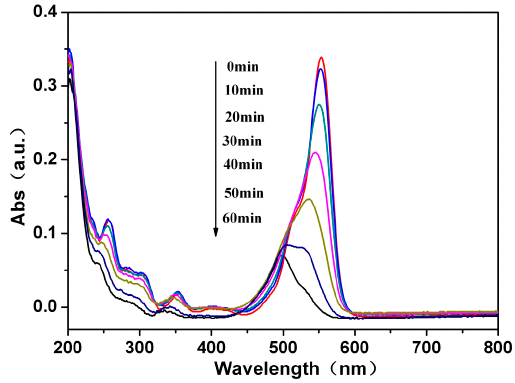
Figure 5. Absorption spectra of the RhB solution after different irradiation time in the presence of photocatalyst composite B/D-70%.